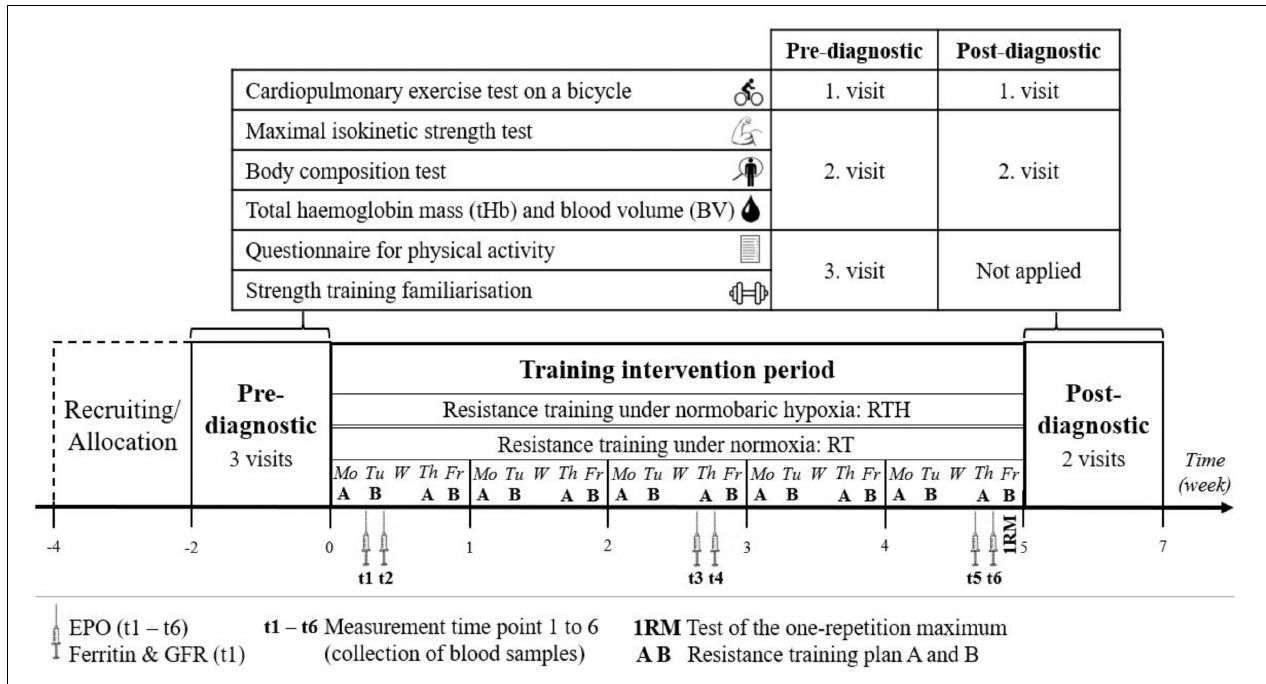
FIGURE 1 | Study design of a 5-week resistance training under hypoxia (RTH) vs. normoxia (RT) with a 2-week pre- and post-diagnostic phase [erythropoietin (EPO) and glomerular filtration rate